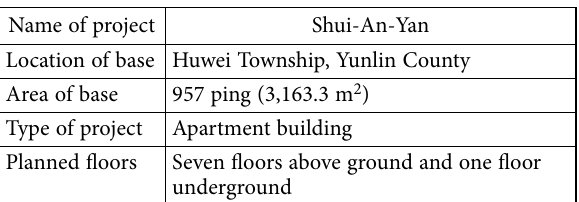
Table 5. Project